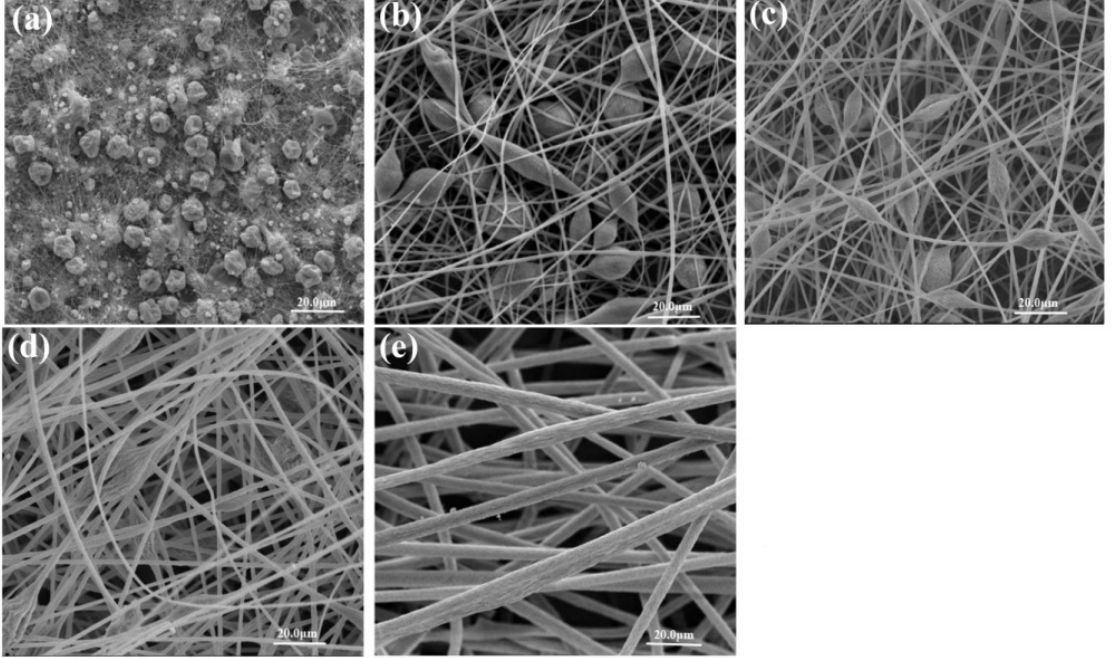
Figure 5. Scanning electron micrographs of electrospun PS fibers on stationary Al foil of 80 rpm and applied voltage of 15 kV with different concentrations of PS/DMF